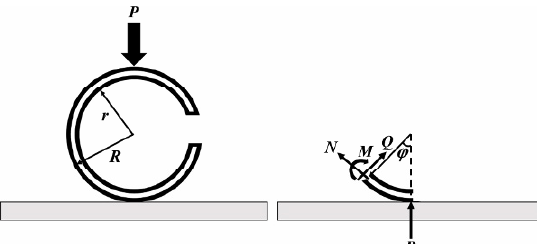
Fig. 5 Schematic diagram of force analysis of the split ring